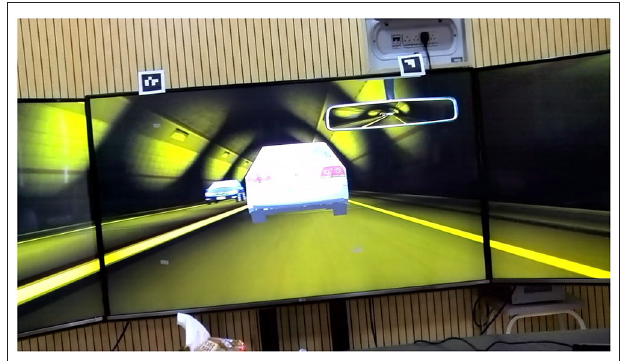
FIGURE 3 | Schematic diagram of the internal environment of the tunnel.